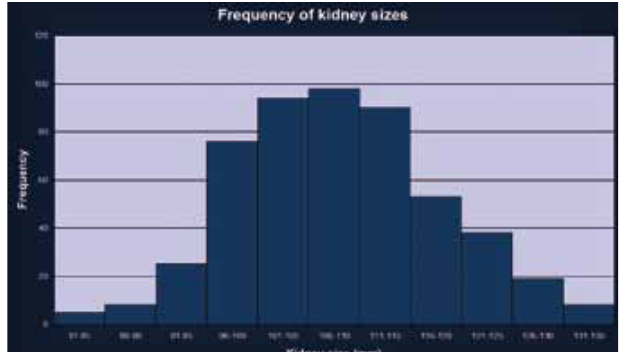
Fig. 2. Distribution of kidney sizes.